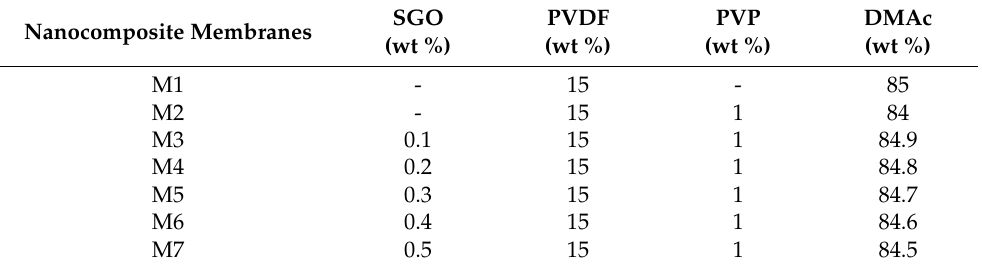
Table 1. Composition of different nanocomposite